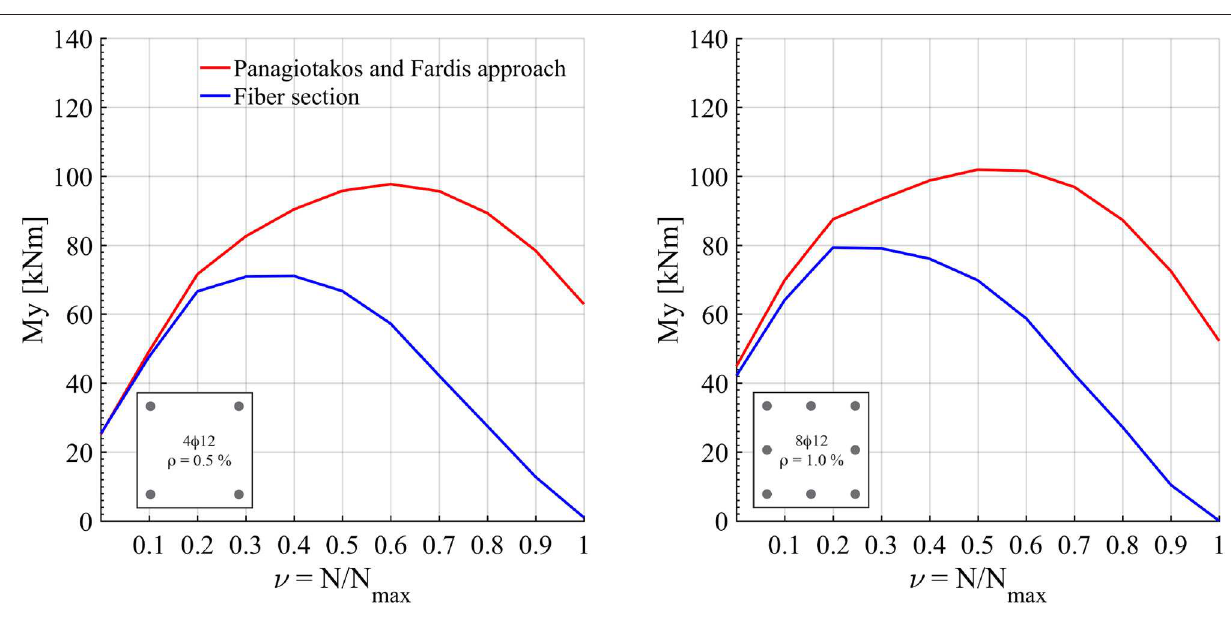
FIGURE 3 | Comparison between Axial Load-Yield Moment interaction diagrams obtained following a fiber section model and Panagiotakos and Fardis (2001)